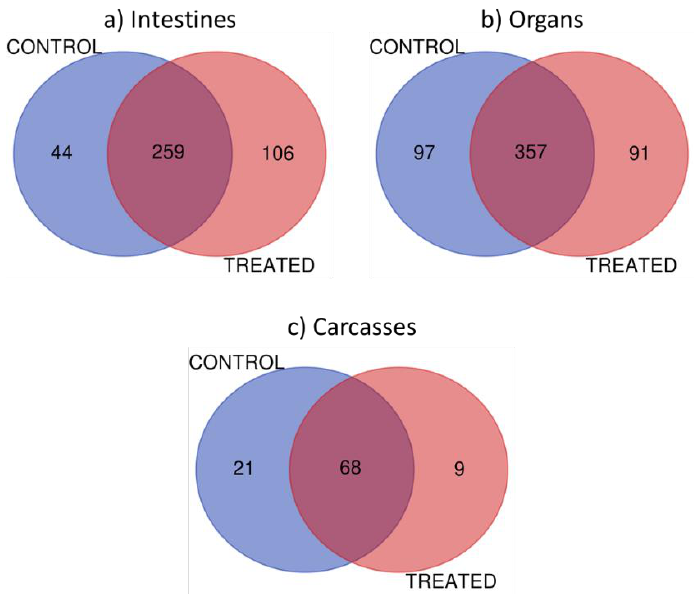
Figure 2. Venn diagram showing the number of identified proteins in Medaka. ( a ) Intestine with 409 total proteins identified, ( b ) organs with 545 identified proteins, and ( c ) carcasses with 98 identified proteins.